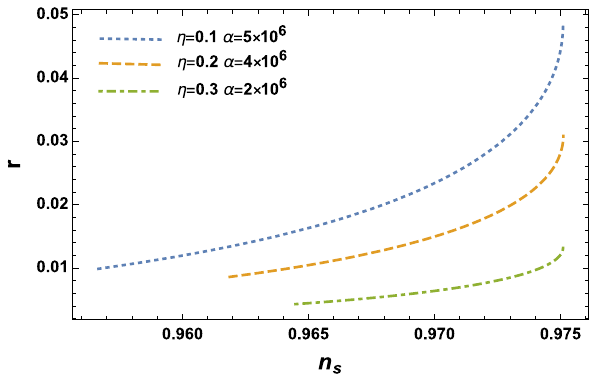
Fig. 14 n s vs r for N = 60 and 0 . 001 ≤ f ≤ 0 . 1 ( M p = 1). As η gets closer to 3 / 8, r gets smaller and is suppressed for η = 3 /